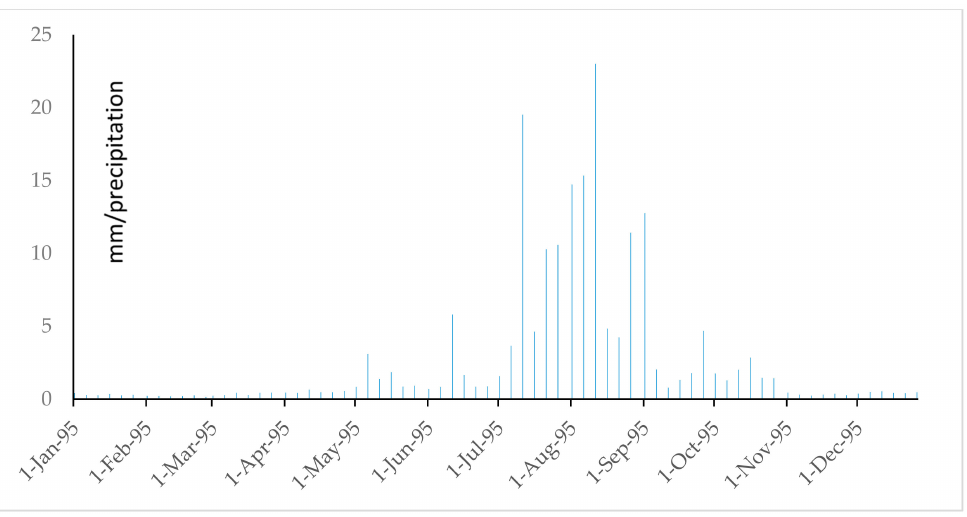
Figure A22. Precipitation of Denko County in 1994.